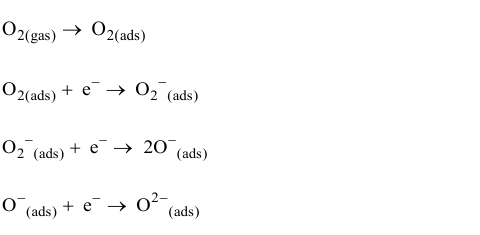
-5 gas sensor at 3